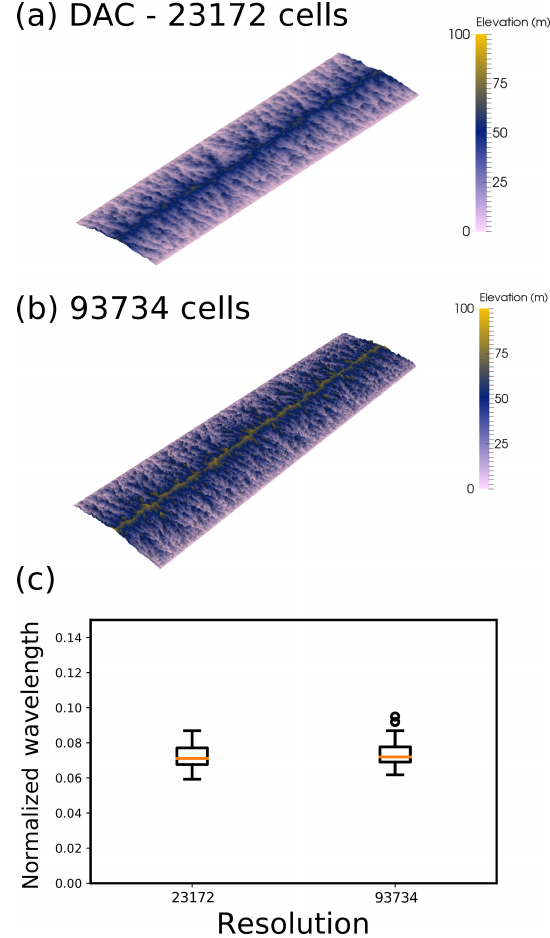
Figure 8. Comparison of two model results using Divide And Cap- ture (DAC; Goren et al., 2014) at different resolutions. (a) Model steady state for an initial resolution of 51 by 204 cells, which af- ter adaptive re-meshing increases to 23172 cells. (b) Model steady state for an initial resolution of 101 by 404 cells, which after adap- tive re-meshing increases to 93734 cells. (c) Comparison of the wavelength of valleys for the two models, taken from 20 swaths 1.25km wide from the left-hand boundary (see code availability for python scripts and DAC input